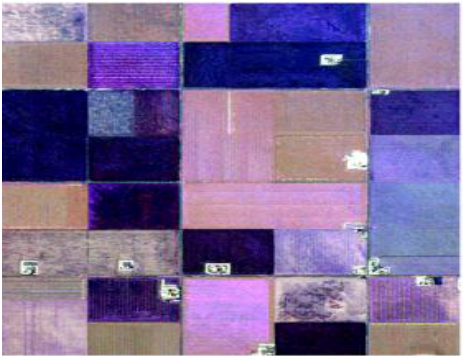
Figure 2. Color composite of Pauli decomposition (R= 𝑆 ℎℎ + 𝑆 𝑣𝑣 , G= 𝑆 ℎℎ − 𝑆 𝑣𝑣 , B= 𝑆 ℎ𝑣